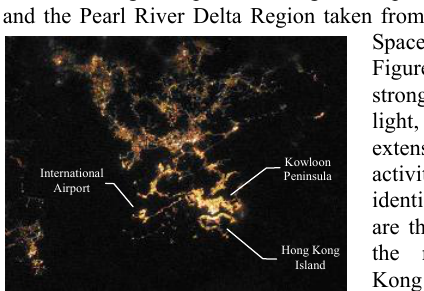
International Airport.